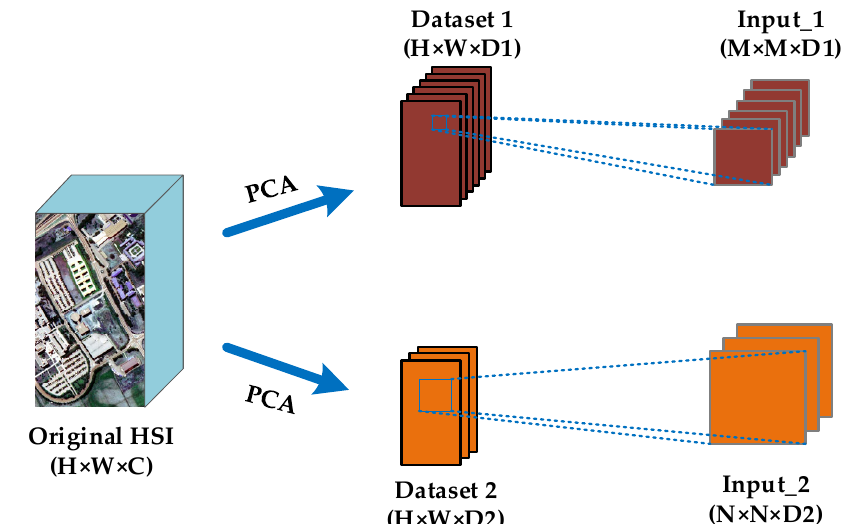
Figure 5. Construction of two inputs with different spectral dimensions and spatial sizes.